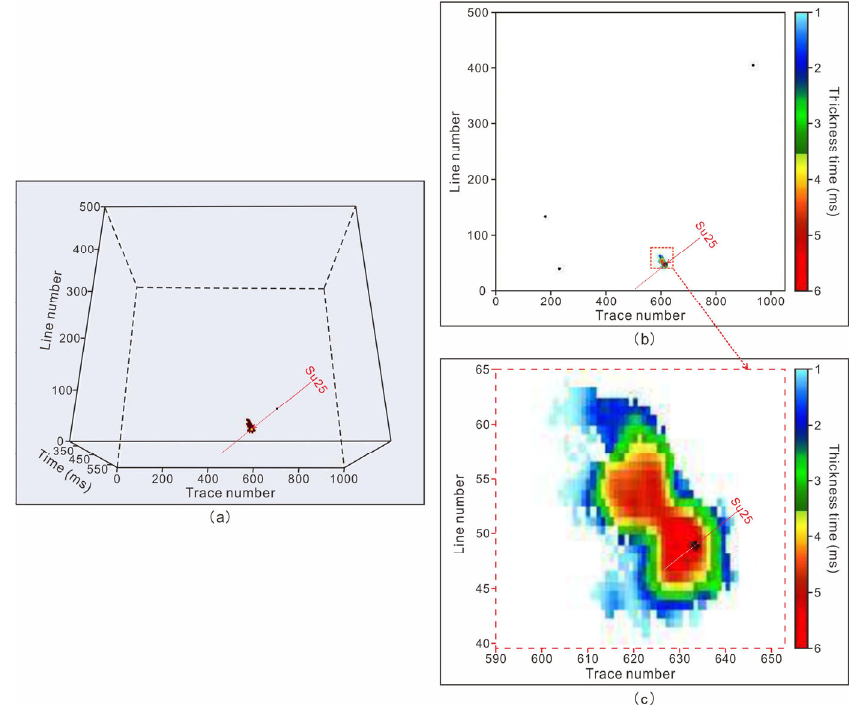
Figure 13. The 3D spatial range and its plane distribution characteristics along the target stratum of the sand body with uranium around Well Su25: ( a ) 3D spatial range, ( b ) Plane distribution characteristics extracted along the target stratum, ( c ) Local enlargement of the red rectangular dashed box in ( b ).